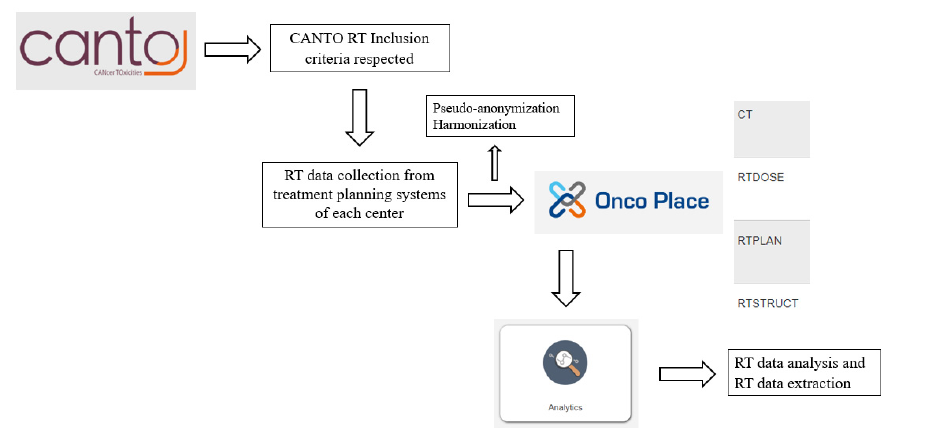
Figure 3. Radiotherapy (RT) Data Collection.